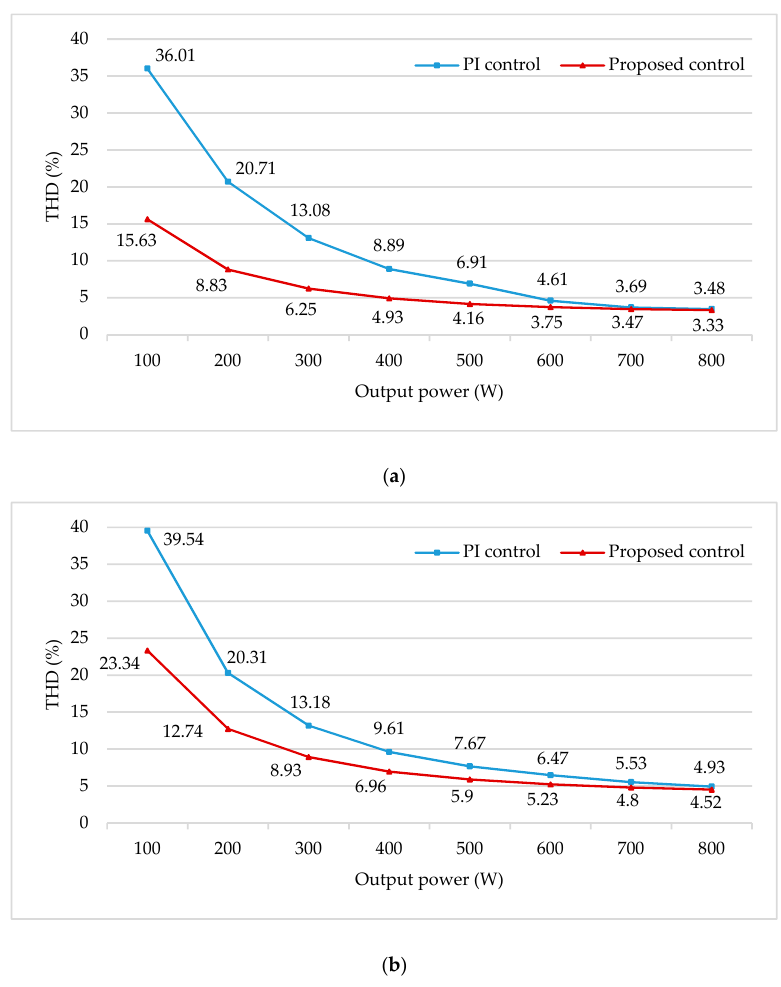
Figure 15. Input current total harmonic distortion comparison results at different load conditions: ( a ) THDs in buck mode; ( b ) THDs in boost